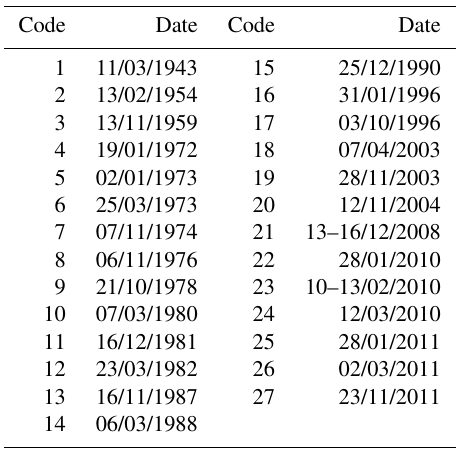
Table 1. Gimigliano: list of the selected 27 landslide events. Code Date